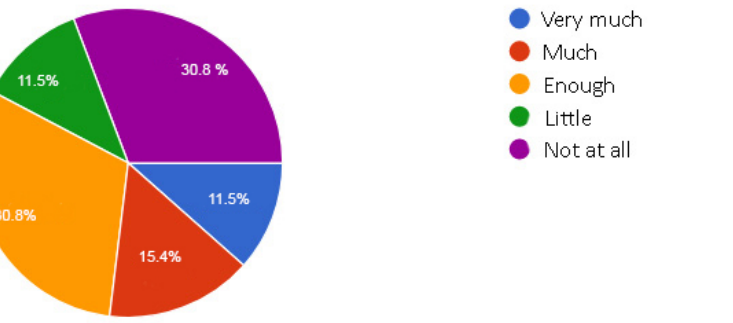
Figure 7. A total 26.9%know quite a lot about smart bin technology, 30.8% know enough and 42.3% know almost nothing about